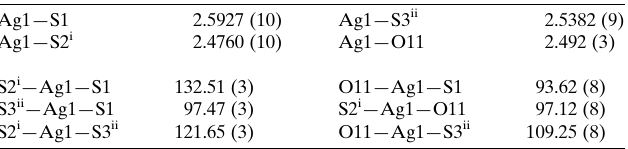
Table 2 Selected geometric parameters (A˚ , (cid:5) ) for II . Ag1—S1